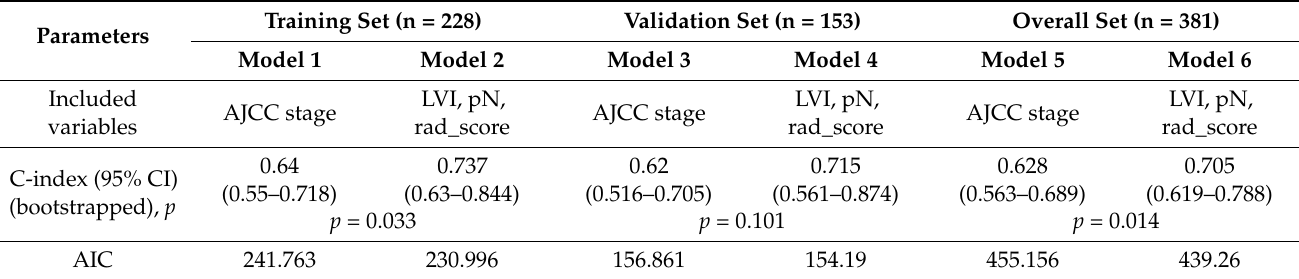
Table 5. Comparison of C-index and Akaike information criterion (AIC) between radiomics nomogram and AJCC stage in the training, validation, and overall